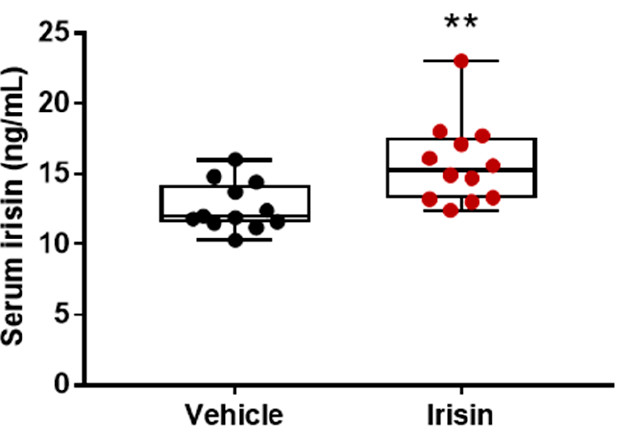
Figure 5. Effect of short-term systemic administration of irisin on serum irisin. Shapiro–Wilk test and unpaired two-tailed Student’s t -test were used for statistical analysis. Data are presented as box-and-whisker with median and interquartile ranges, from max to min, with all data points shown. n = 12 mice per group. ** p = 0.0045.